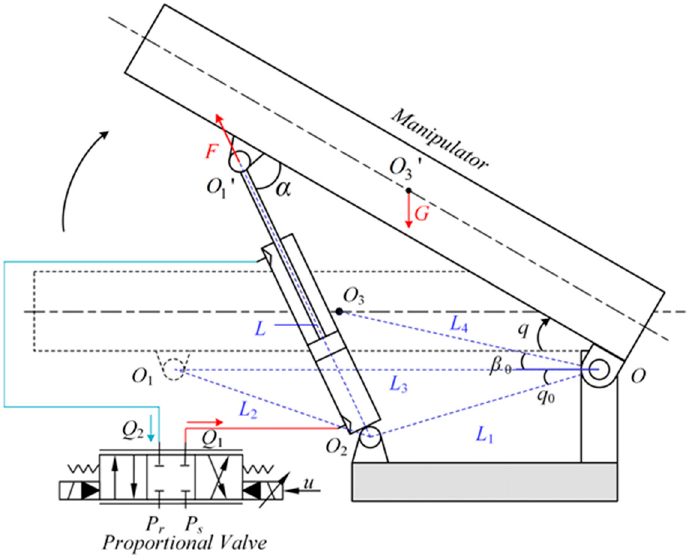
Figure 1. The motion schematic diagram of hydraulic lifting manipulator.